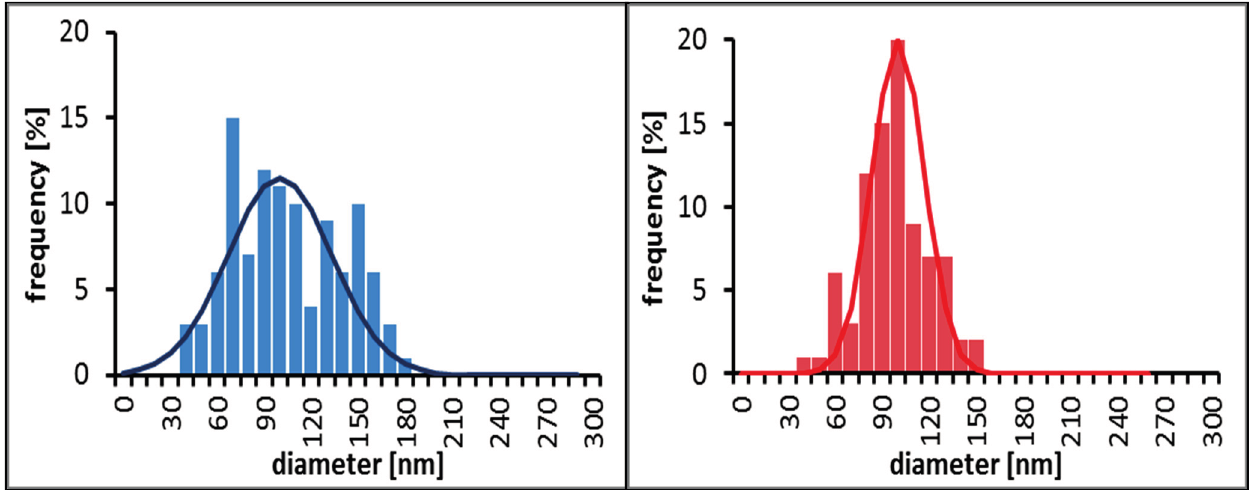
Figure 4. Size distribution based on TEM and STEM micrographs of Sample A ( left ) and Sample B ( right